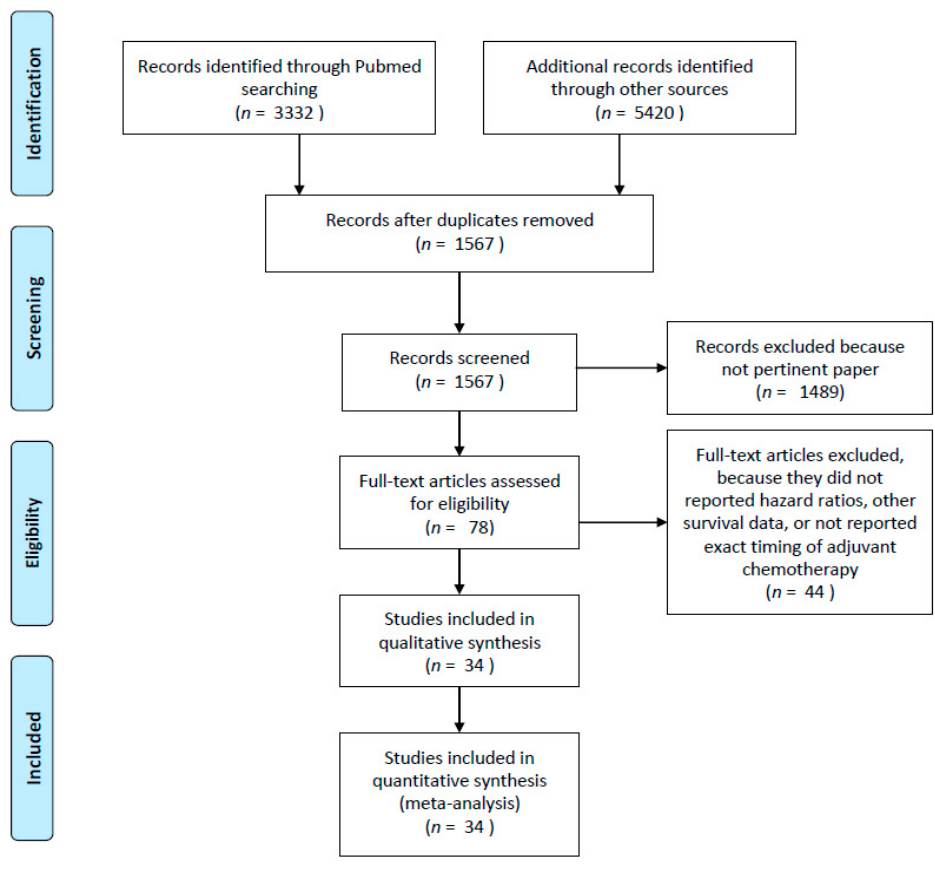
Figure 5. Flow diagram of included studies.